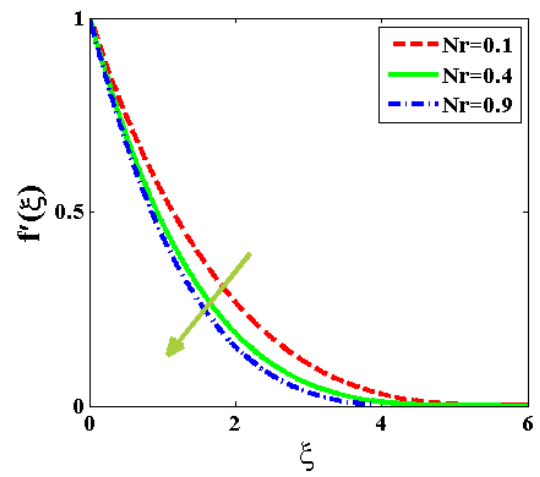
Figure 10. Outlines of 𝑓 ′ at diverse quantities of 𝑁𝑟 .